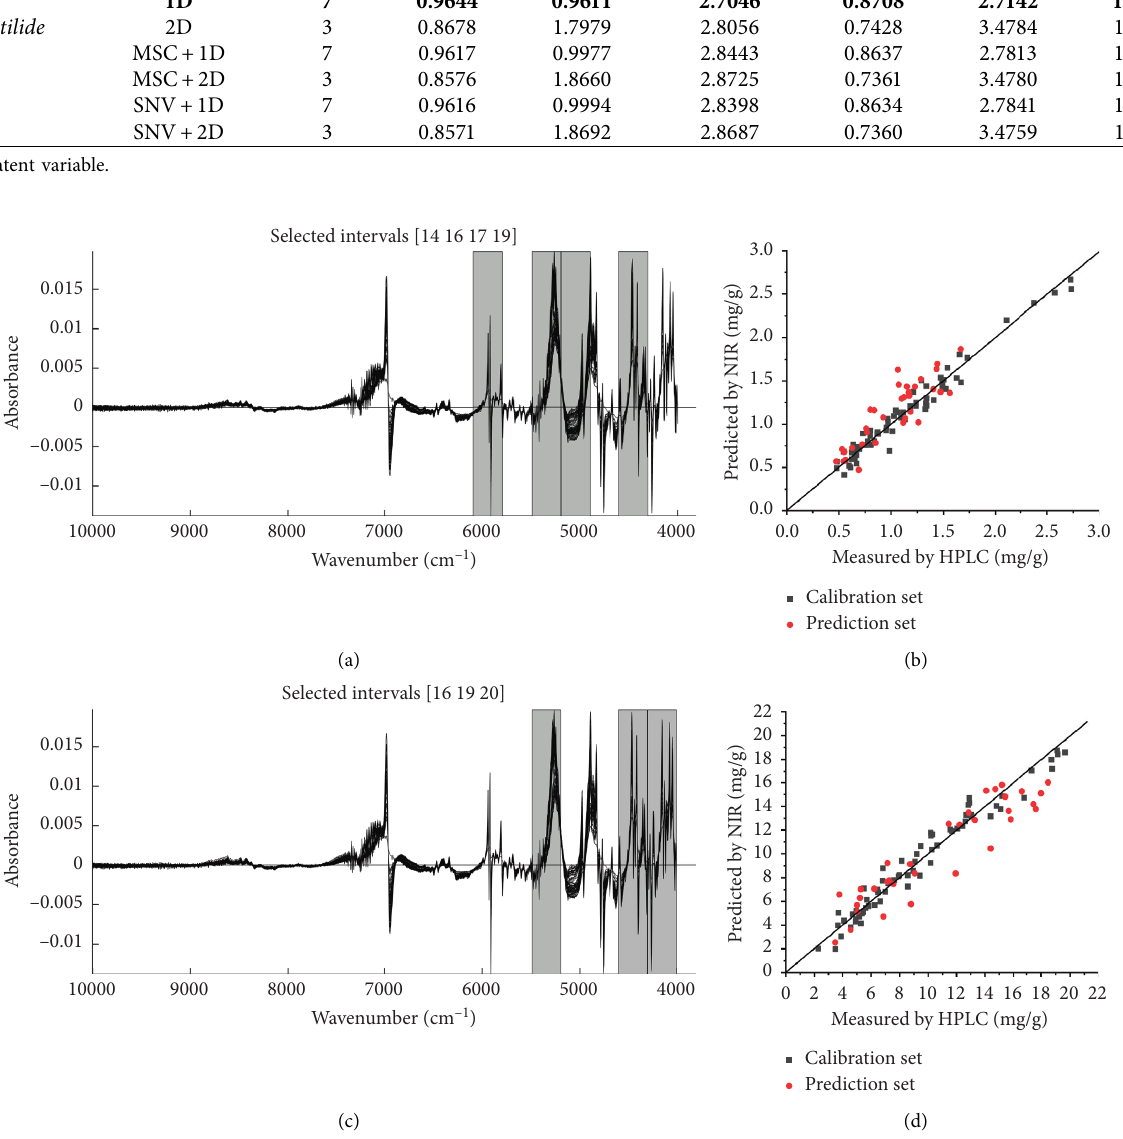
Figure 5: Measured versus predicted plot (b and d) for the concentrations of ferulic acid and Z-ligustilide by the best PLSR models obtained with the optimal spectral interval combinations (a and c). Ferulic acid (a and b), Z-ligustilide (c and